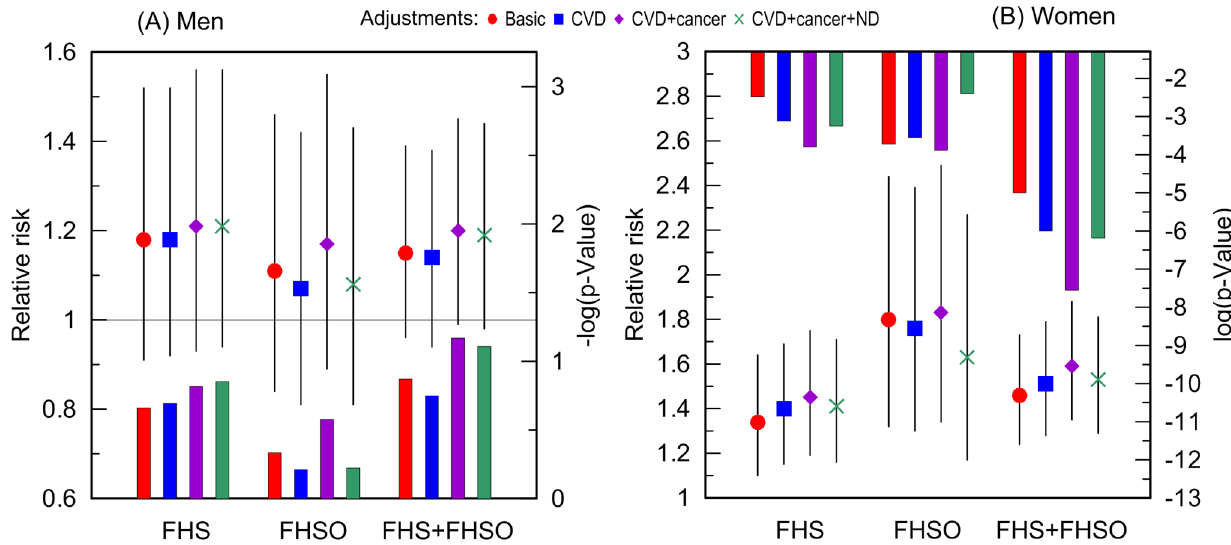
Figure 3. Relative risks of death and p-values for the ApoE4 allele carriers compared to the non-carriers. The risks were evaluated in more homogeneous groups of (A) men and (B) women who died or were right censored at ages: (i) younger than 95 years in the FHS, (ii) 70 years and older in the FHSO, and (iii) 70 to 95 years in the pooled sample of the FHS and FHSO cohorts. The basic model denotes adjustment for birth cohorts (all models) and an indicator of the FHS or FHSO in the pooled sample (FHS + FHSO). Adjustments by diseases are additional to the basic adjustment. Thin bars show 95% confidence intervals. Exact numeric values for the estimates and sample sizes are given in Supplementary Table S1. Right y-axes show (A) minus log-base-10-transformed p-values and (B) log-base-10-transformed p-values. (A) The horizontal line and (B) upper x-axis show the conventional level of significance, i.e., |log 10 (0.05)|=1.3. doi:10.1371/journal.pgen.1004141.g003 analyses in this study show no mediating role of cancer in the CVD and cancer are the most common causes of death in association of the e4 allele with women’s survival; the additive humans and ND is fast growing cause of death in the elderly. CVD contribution of cancer, however, can modulate the effect of the e4 and ND are the diseases which have been most consistently allele, increasing the strength of this association (Figure 3). associated with ApoE4. Despite that, these diseases do not explain